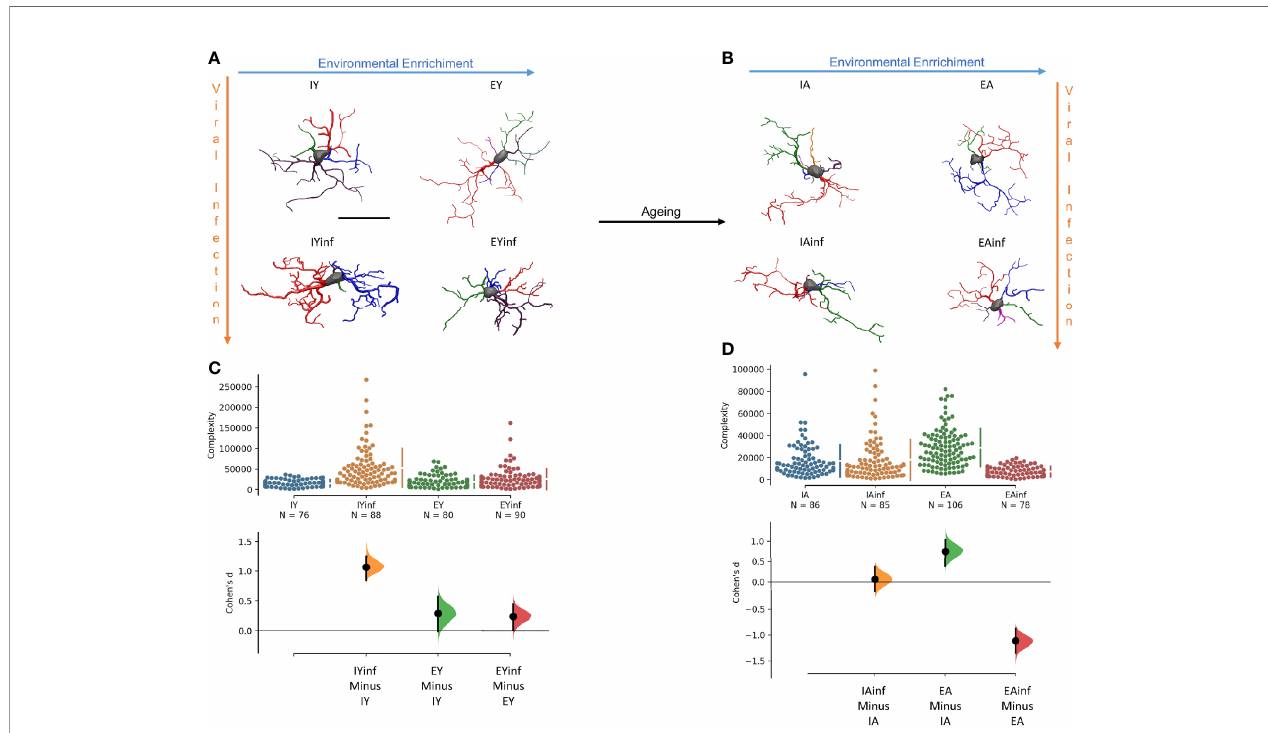
FIGURE 6 | Age and environmental in fl uences on microglial morphological response in a mouse model of sublethal encephalitis induced with Piry arbovirus. Three- dimensional reconstructions of the “ mean cell ” of each experimental group are shown, including control and infected young mice (A) , control and infected aged mice (B) . Microglia complexity of young (C) and aged (D) control and infected mice, under the in fl uence of impoverished and enriched environments, with corresponding Cohen ’ s effect size was calculated as the mean difference divided by the standard deviation of differences. Notice that aging seems to minimize morphological changes, and effect size under neurotropic infection is greater in young mice maintained in impoverished environments. To choose the representative (mean) cell of each group, the distance matrix was used to obtain the sum of the distances of each cell in relation to all the others. We assumed that the cell that best represents each group is the one with the least sum of distances. The matrices were constructed using all morphometric variables with the combination of all cells of a given group, followed by the weighted calculation of a scalar Euclidean distance between the cells. IY, young mice raised in impoverished environment; EY, young mice raised in enriched environment; IA, aged mice raised in impoverished environment; EA, aged mice raised in enriched environment; IYinf, infected young mice raised in impoverished environment; EYinf, infected young mice raised in enriched environment; IAinf, infected aged mice raised in impoverished environment; EAinf, infected aged mice raised in enriched environment. Scale bar = 25